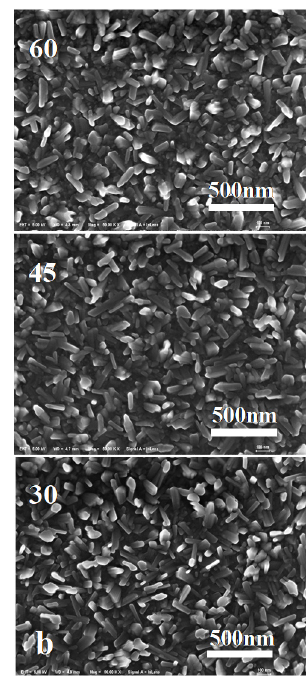
Figure 3. XRD patterns ( a ) and SEM images ( b ) of the VO 2 thin films prepared by professional annealing of the 30, 45, 60 nm V metal films at 450 Pa, 400 °C for 1 h.